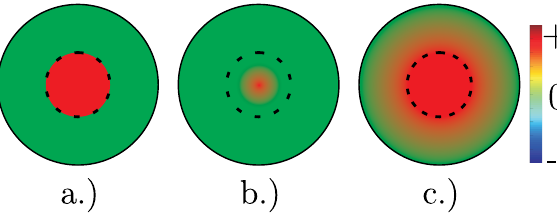
Fig.1: Sample sensitivity distributions and their impact on the criteria Selectivity Sel and Homogeneity Hom . a.)